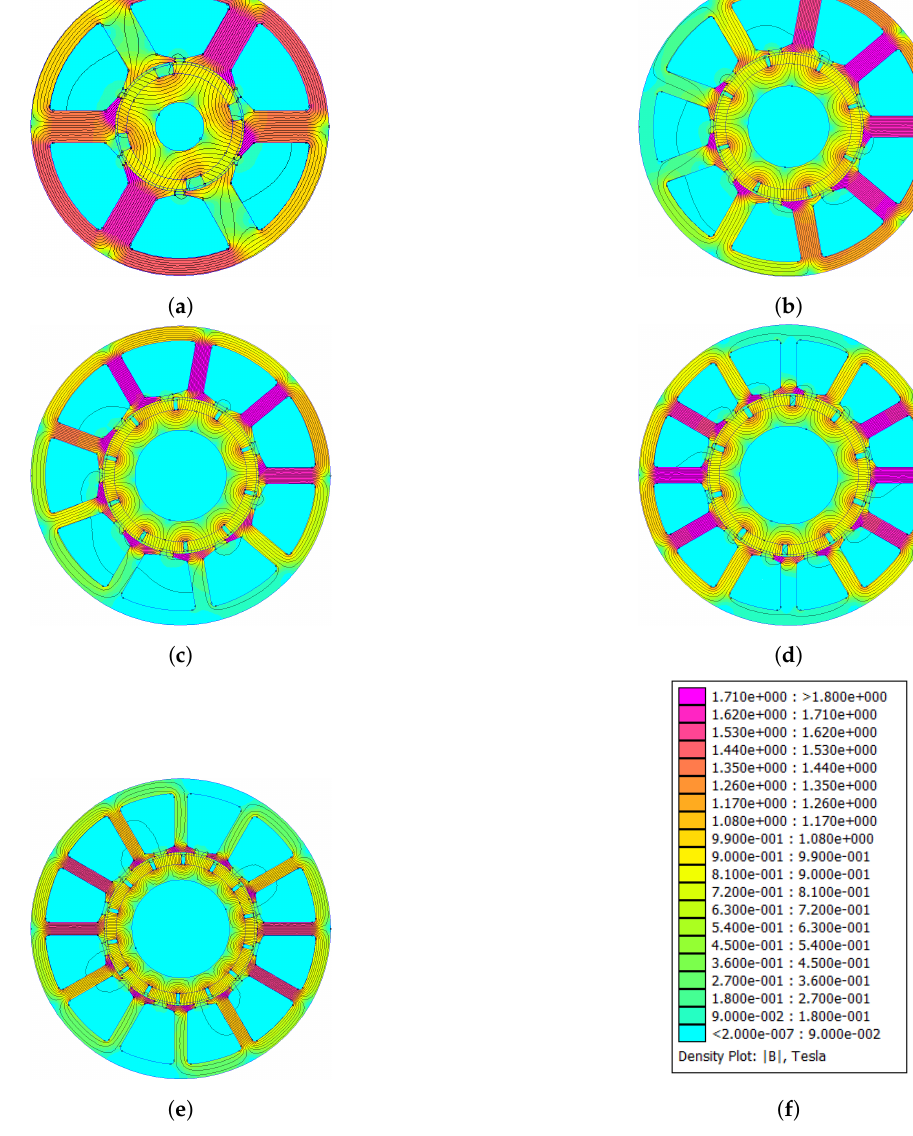
Figure 2. Distribution of magnetic flux density of optimized machines: ( a ) 6-4; ( b ) 9-8; ( c ) 9-10; ( d ) 12-10; and ( e )